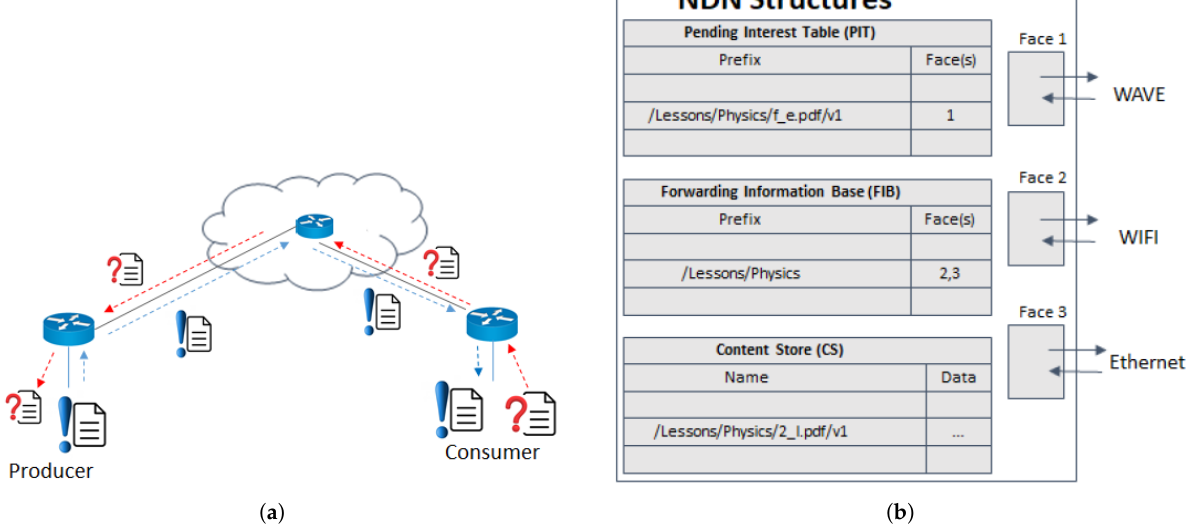
Figure 2. NDN basic principle. ( a ) Consumer and Producer interaction. ( b ) Node’s control